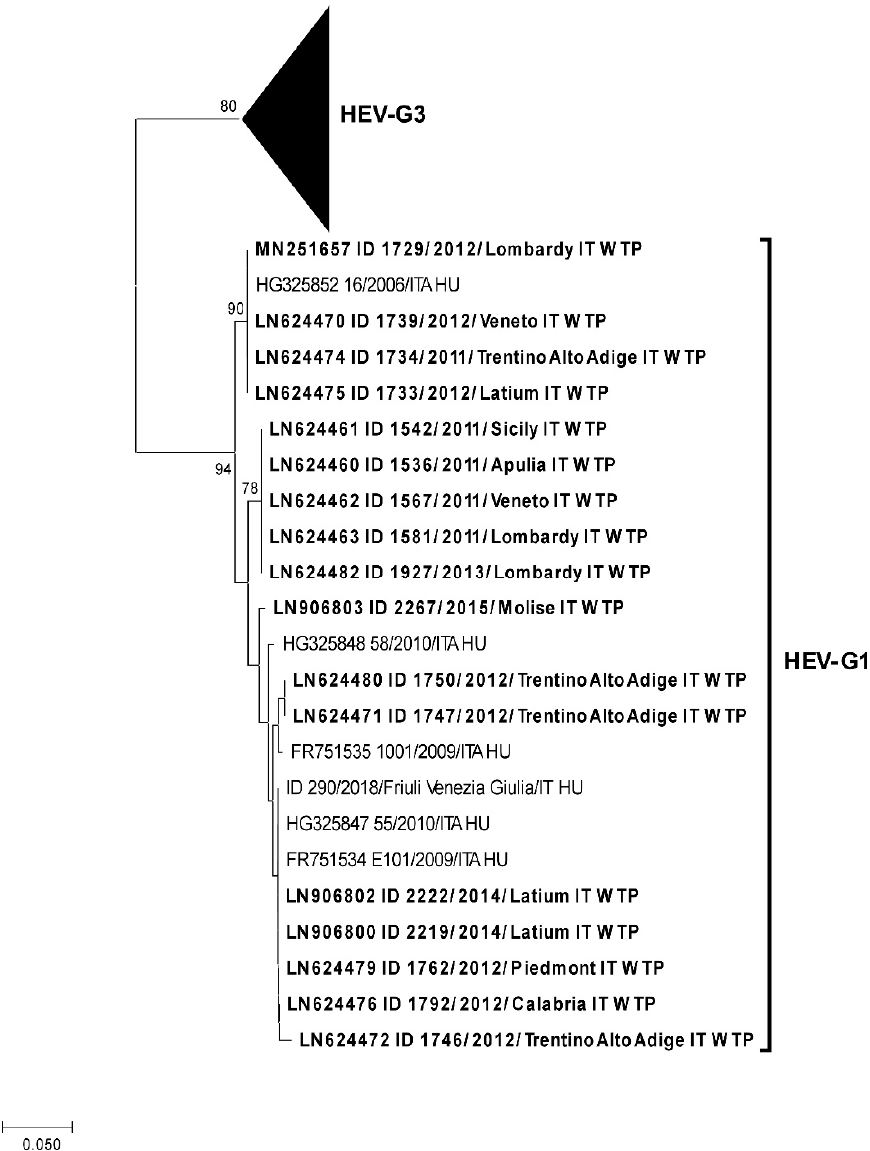
Figure 4. ( B ) Neighbor-joining phylogenetic tree of HEV-G1 sequences. Figure 4. ( top ) Neighbor-joining phylogenetic tree of HEV-G3 sequences. ( bottom ) Neighbor-joining phylogenetic tree of HEV-G1